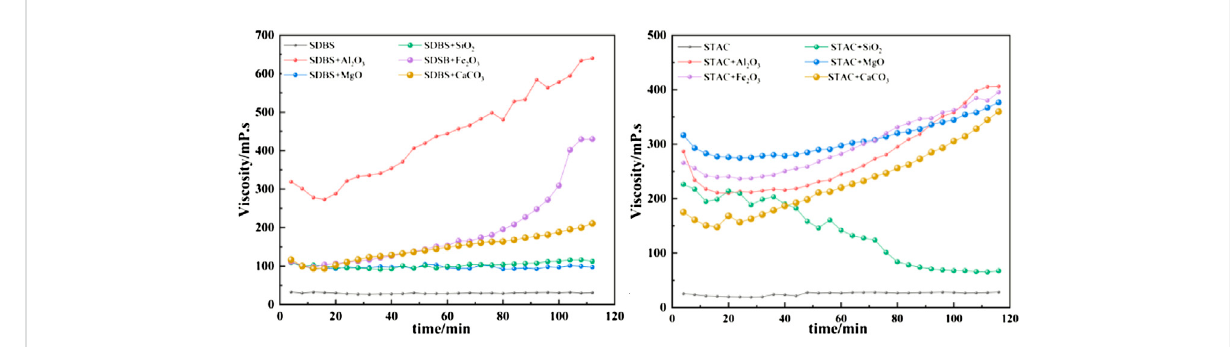
FIGURE 11 Viscosity growth curves for the anionic (SDBS) and cationic (STAC) emulsi fi ed asphalt mortars.